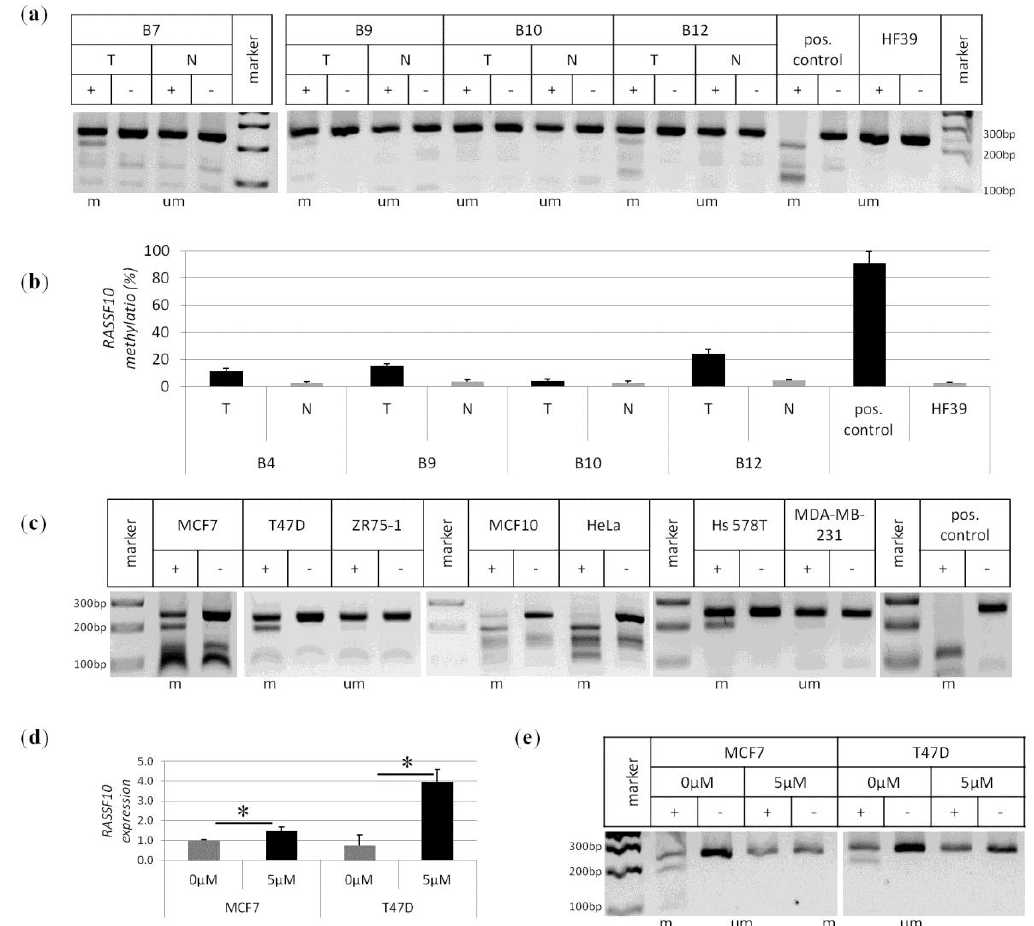
Figure 2. RASSF10 promoter methylation in primary breast tumours and breast cancer cell lines. ( a ) RASSF10 COBRA promoter methylation analysis is shown exemplarily for samples of primary breast cancer (T) and normal matching control tissues (N). Positive control shows full methylation of RASSF10 promoter vs. human fibroblasts HF39 as negative control. PCR products for the RASSF10 promoter from bisulfite treated DNA were digested (+) with Taq I or mock digested (−). According digestion products were separated on 2% TBE gel together with 100 bp marker. Methylated samples (m) pyrosequencing for breast tumour samples (T) in comparison to normal matching control samples (N). used. Mean of seven CpGs is shown; ( c ) RASSF10 promoter methylation of cancer cell lines is shown by COBRA. Breast cancer cell lines MCF7, T74D, MCF10 and Hs578T are methylated to a varying